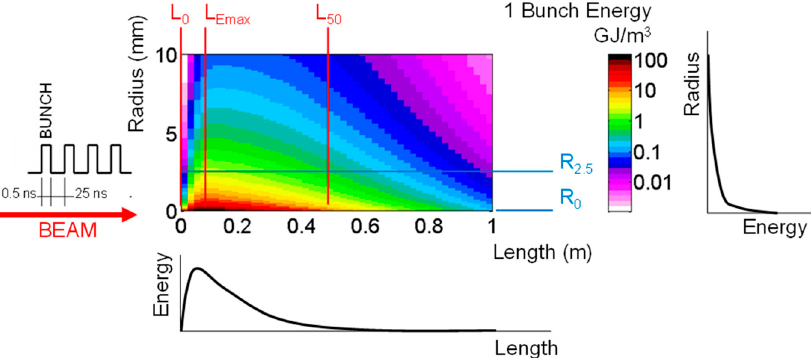
Figure 1. Distribution of the deposited specific energy (GJ/m 3 , logarithmic scale) in a tungsten block hit at the center of one basis (result of the FLUKA calculation [33]).